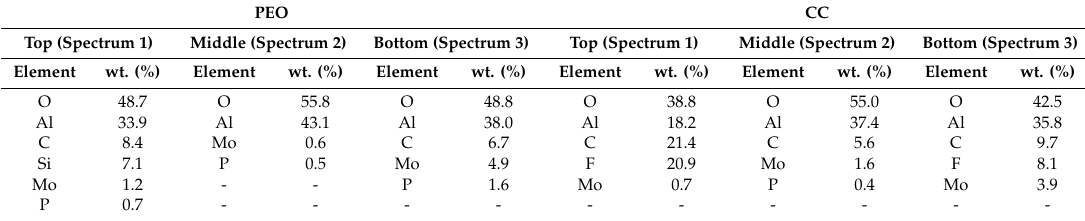
Figure 12. SEM image and EDX maps of the CC’s cross-section after 30 days of atmospheric exposure. Table 6. Elemental composition at di ff erent locations across coatings’ thickness after 30 days of atmospheric exposure (Figures 11 and